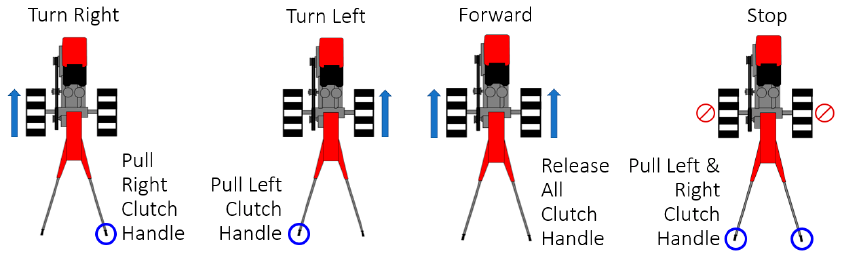
Figure 4. G1000-Quick Walk-Behind Tractor movement control.